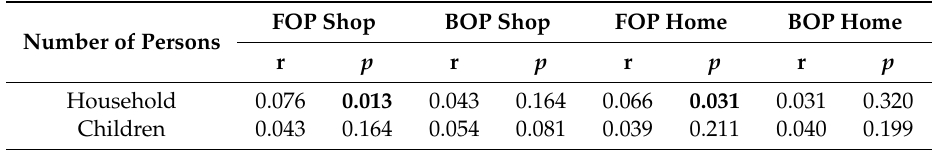
Table 7. Pearson correlation coe ffi cients of reading food labels with the size of one’s household and the number of